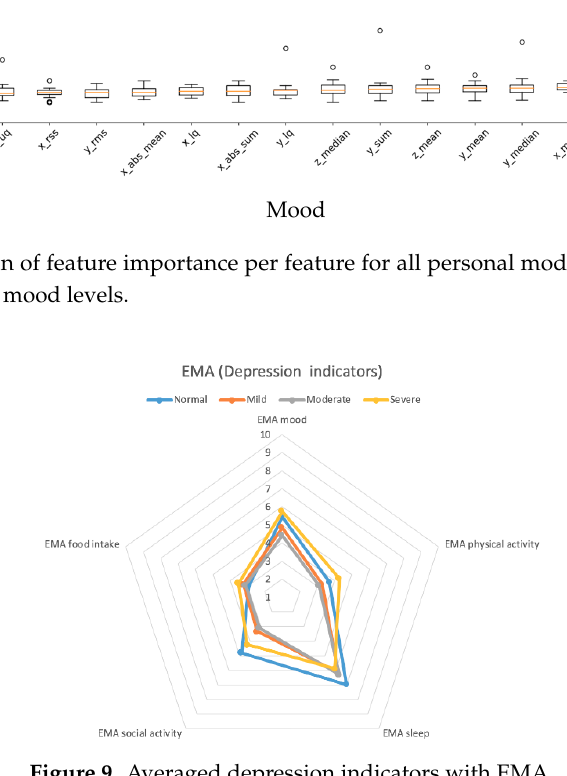
Figure 9. Averaged depression indicators with EMA.